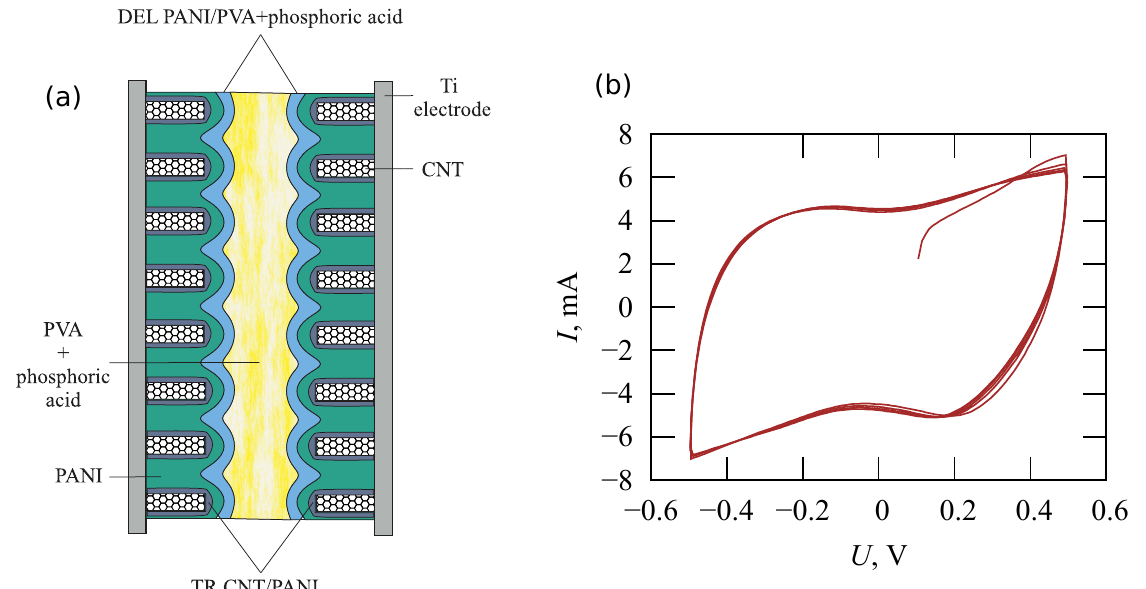
Figure 6. Schematic representation of the cell with polyaniline/vertically aligned carbon nanotube array electrodes ( a , b ). Voltammogram for pseudocapacitors for potential sweep speed of 100 mV/s.